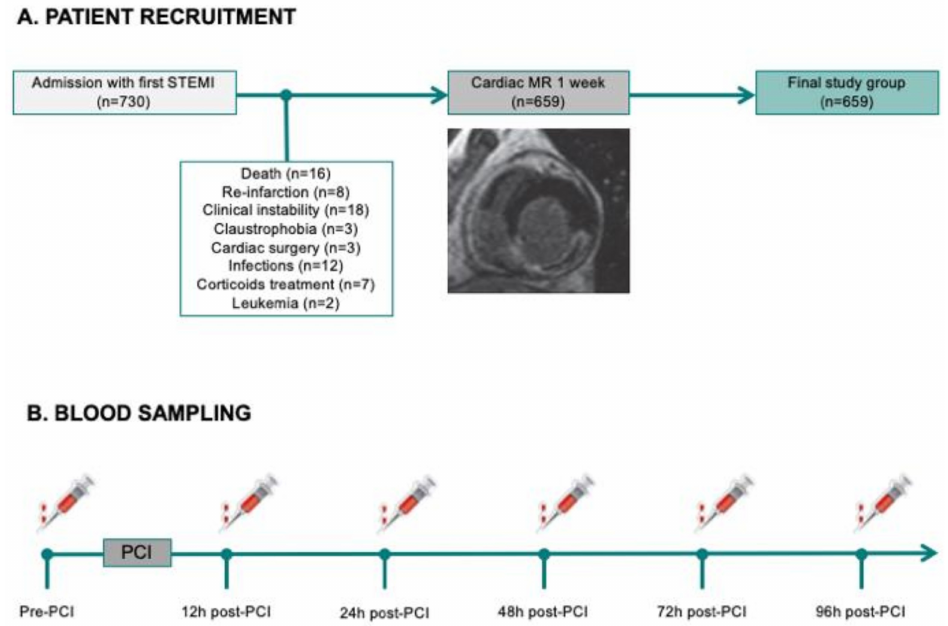
Figure 1. Flowchart of the STEMI study group, showing STEMI patient recruitment ( A ) and blood sampling ( B ). MR: magnetic resonance; PCI: primary coronary intervention; STEMI: ST-segment elevation myocardial